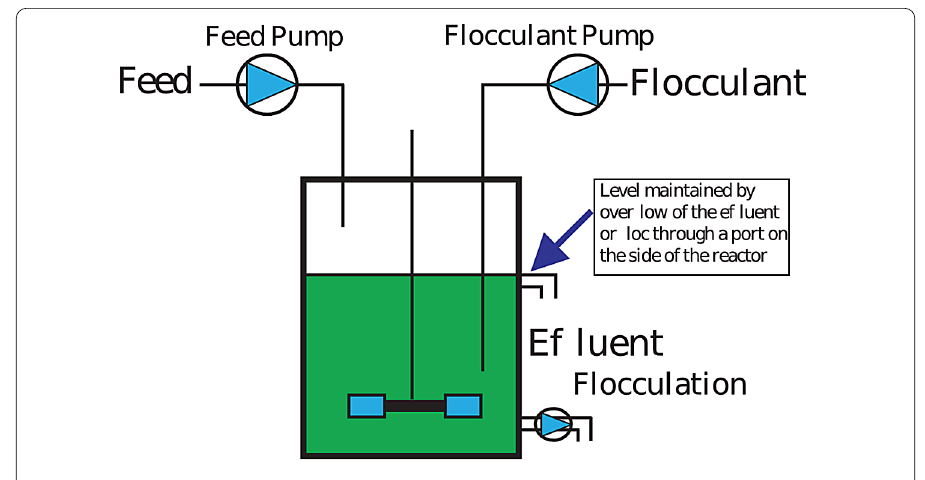
Figure 2 The modified